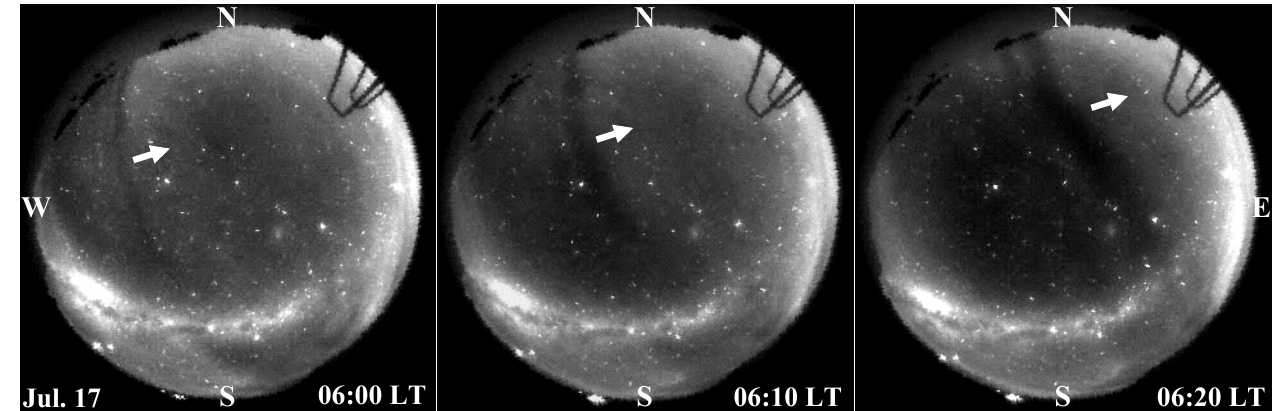
Fig. 1. Three individual all-sky images obtained in the night of 16–17 July 2007 showing a mesospheric front propagating approximately from West to East. The observations time are shown in the right bottom